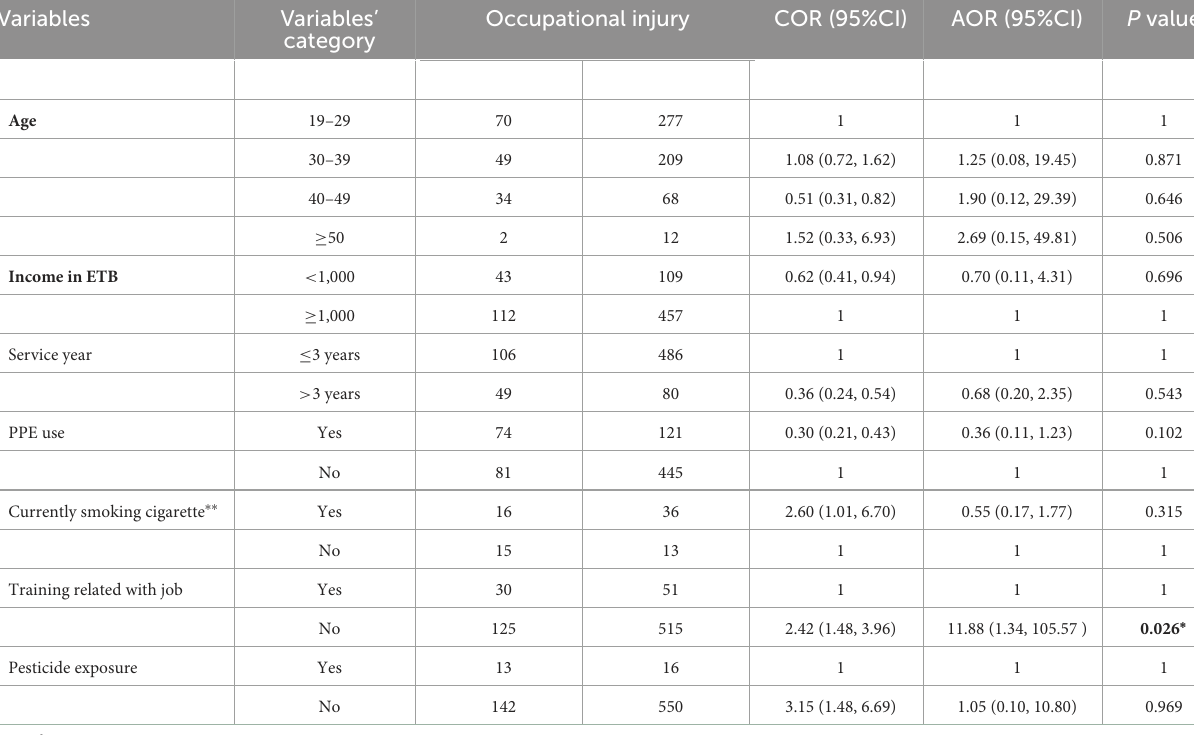
TABLE 5 Factors associated with work related injuries, Bench-Sheko and Kafa Zones, May/2021.